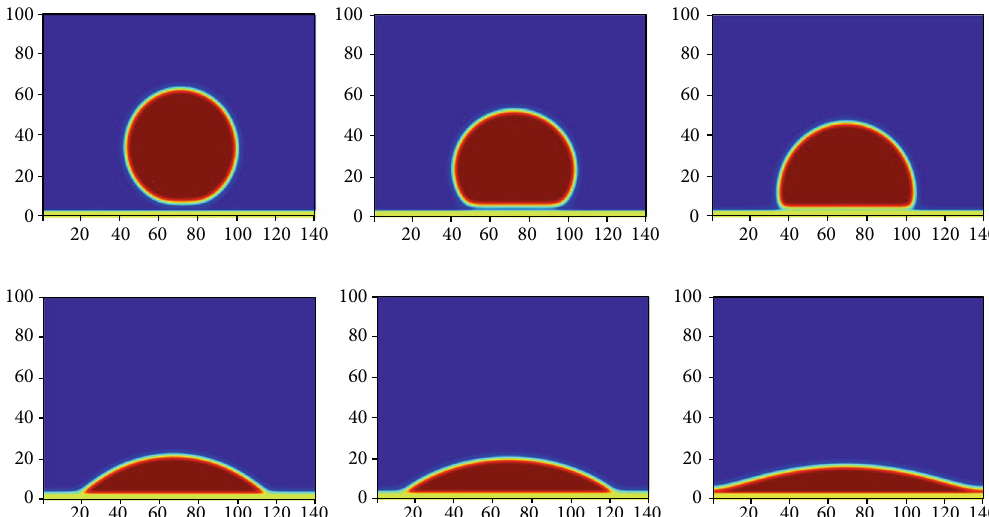
Figure 5: Simulation of di ff erent contact angles by adjusting the e ff ective solid mass φ and interface between gas and water yellow.